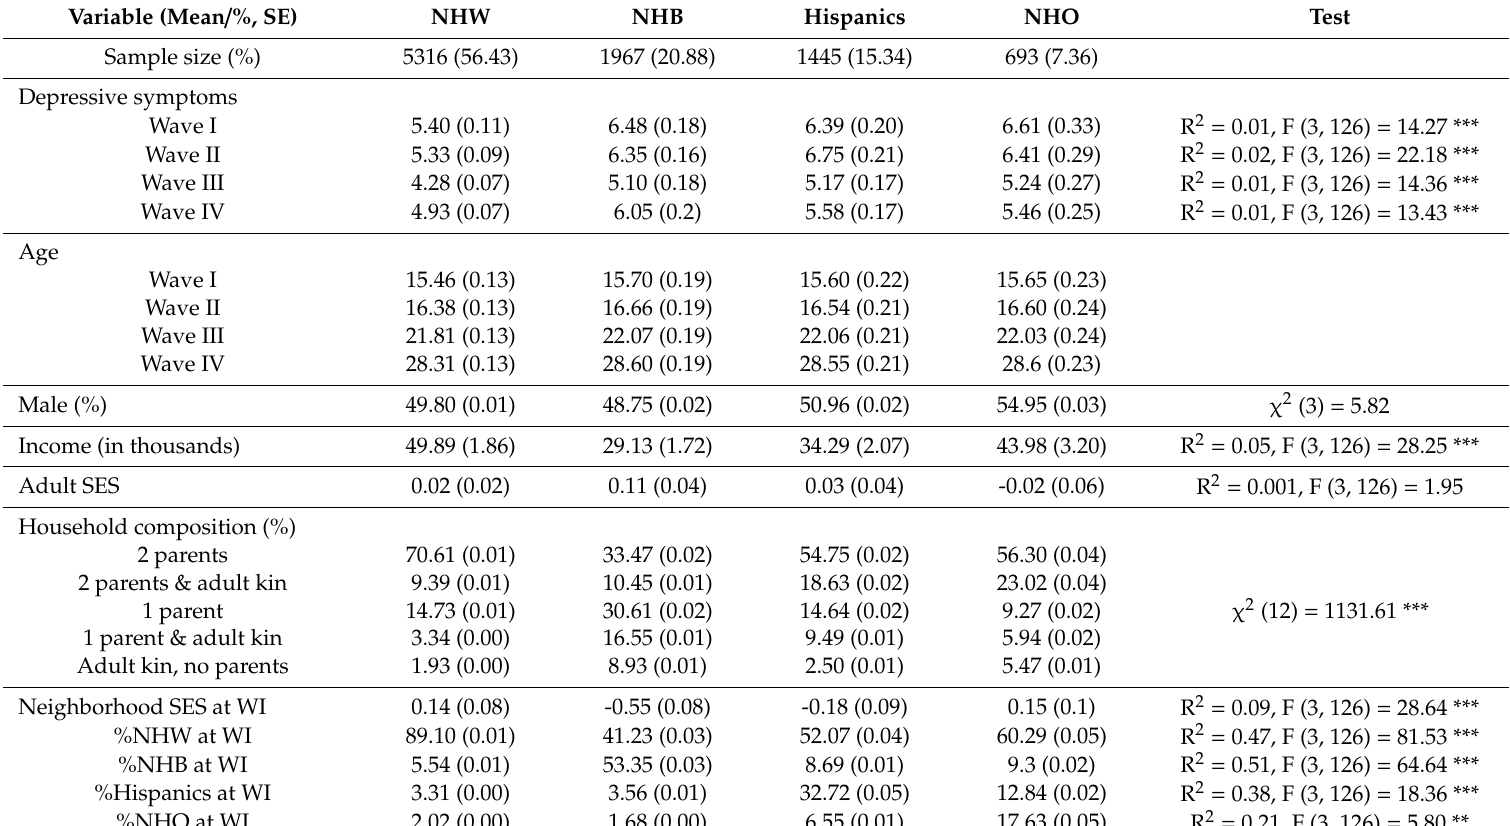
Table 1. Descriptive statistics and tests of di ff erence by racial / ethnic